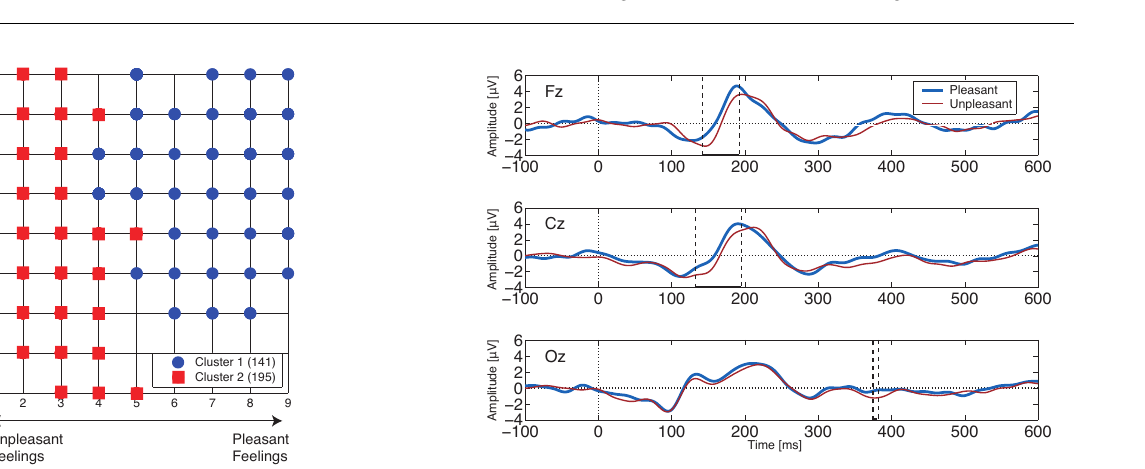
Figure 2. Results of cluster analysis of viewer’s responses using the Affect Grid. (Blue circles indicate “Pleasant” cluster and red blocks indicate “Unpleasant” cluster) [30].